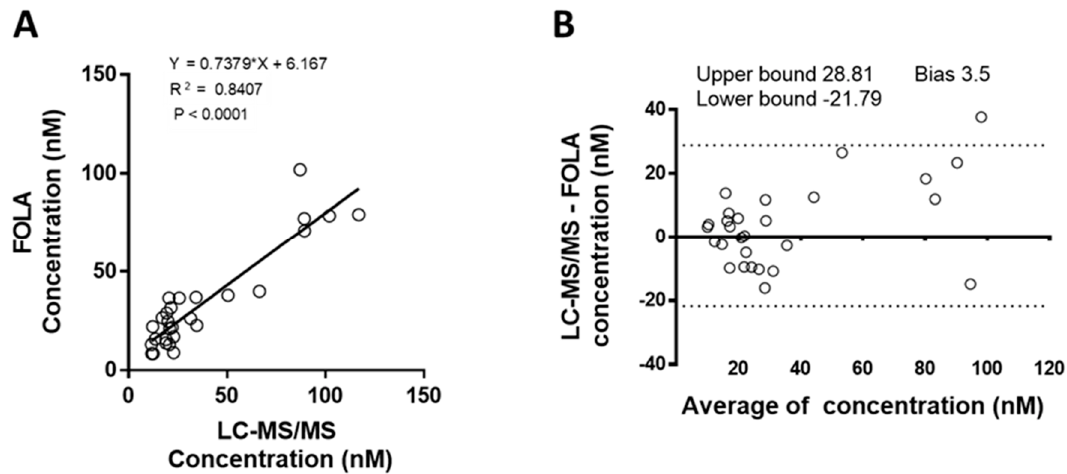
Figure 2. Correlation between FOLA and LC-MS / MS measurement. A series of 28 samples was measured with the new method and results were compared with measurements with an LC-MS / MS method. The chemiluminescent method measures all folate forms, while for the LC-MS / MS method, the sum of 5-methyl tetrahydrofolate (the main natural form) and folic acid (the synthetic form) is represented. Panel A shows the correlation between both methods, which is further illustrated by the Bland Altman plot in Panel B .